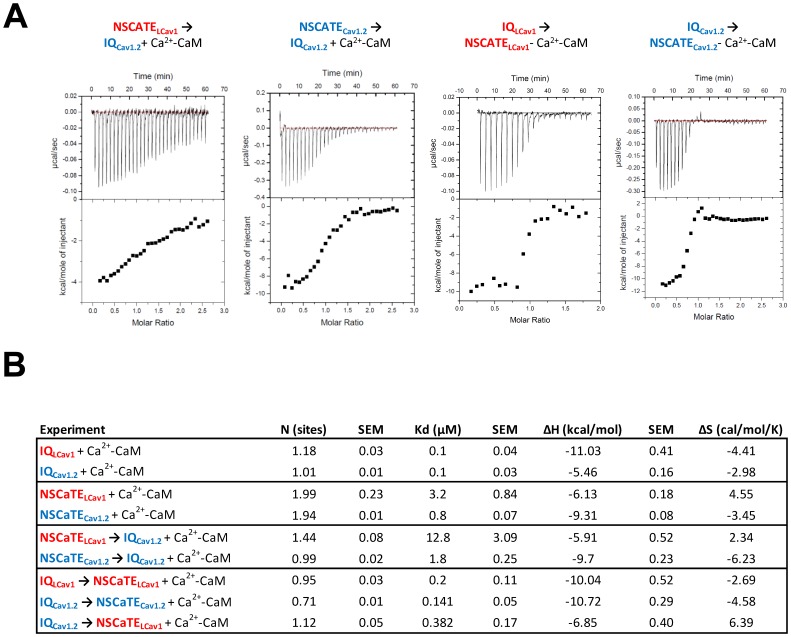
Isothermal Calorimetry (ITC) analysis indicates a 2∶1 stoichiometry of NSCaTE:CaM in the absence of IQ, and a 1∶1 NSCaTE:CaM stoichiometry when CaM is first pre-bound to IQ.(A) Representative raw sample data for several CaM-peptide titrations. (B) Summary Table of ITC data. NSCaTE or IQ peptides were titrated into Ca2+-CaM alone or Ca2+-CaM pre-bound to a competing peptide at a 1∶1 ratio. All binding reactions exhibited negative enthalpy under the experimental conditions used (exothermic, ΔH <0). Despite the lack of mobility shift of Ca2+-CaM (Figure 7), NSCaTE does bind Ca2+-CaM alone. LCav1 and Cav1.2 IQ peptides have a higher affinity (Kd = 80 nM and 130 nM, respectively) for Ca2+-CaM than do either of the NSCaTE peptides (Kd = 0.83 µM and 3.24 µM for Cav1.2 and LCav1 NSCaTEs). Both mammalian NSCaTECav1.2 and snail NSCaTELCav1 is able to bind to Ca2+-CaM pre-bound to IQ motifs, and both IQ peptides are able to bind to CaM when it is first bound to NSCaTE, which is consistent with the possibility of a NSCaTE-CaM-IQ complex in vivo. N values indicate that NSCaTELCav1 and NSCaTECav1.2 can bind to Ca2+-CaM in a 2∶1 stoichiometry, consistent with NSCaTE possibly binding simultaneously to both the N- and C-lobes of CaM, as previously reported [30].